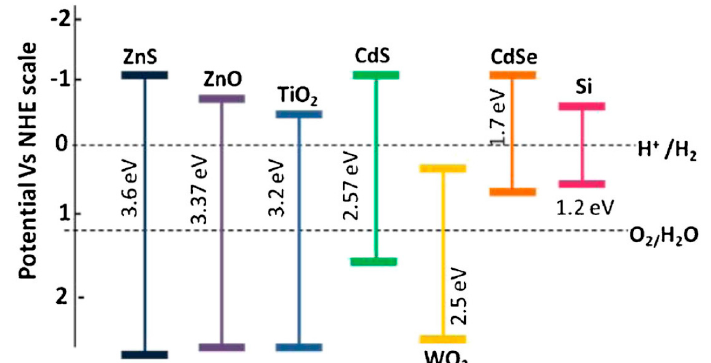
Figure 4. Band gap potential diagram of the most common semiconductors, used as photocatalysts at NHE scale [22]; reproduced from [22] with permission from the Springer Nature.